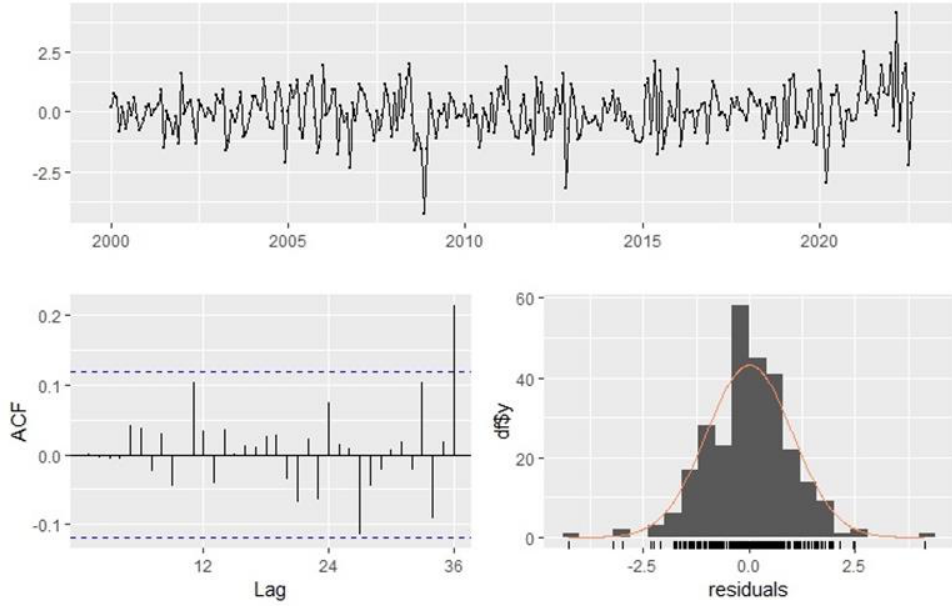
Figure A4. Residuals, ACF, and lags in prediction of CPI Los Angeles. Own processing.